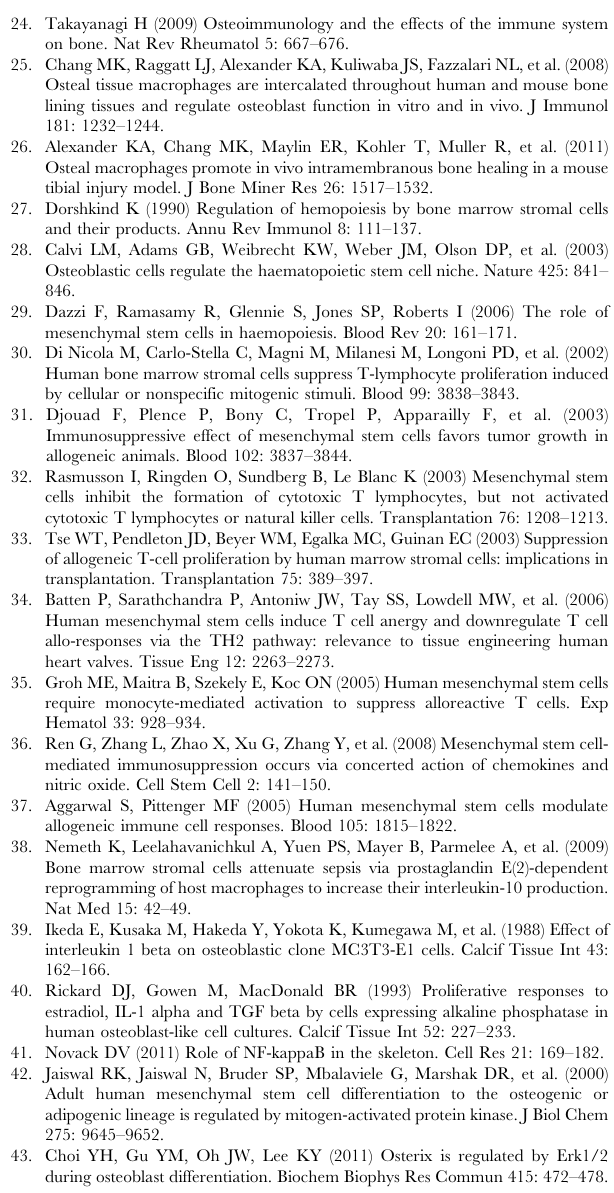
Figure S2 Monocyte osteogenic effect is not mediated by BMPs or TGF b . MSC-macrophage (M w ) co-cultures (ratio 1:10) were established in the presence of neutralizing antibodies against BMP2/4, BMP3, BMP7 and TGF b at 10 m g/ml as well as IgG1 and IgG2B isotype controls and ALP activity quantified after 7 days. Graphs show means 6 SEM of three independent experiments performed in triplicate. Table S1 Supernatant from MSC alone cultures and 10:1 monocyte/MSC co-culture were tested for the presence of BMP2, BMP4, BMP7 and TGF b 1 using individual, commercially available enzyme-linked im- munosorbent assays (all from R&D systems,